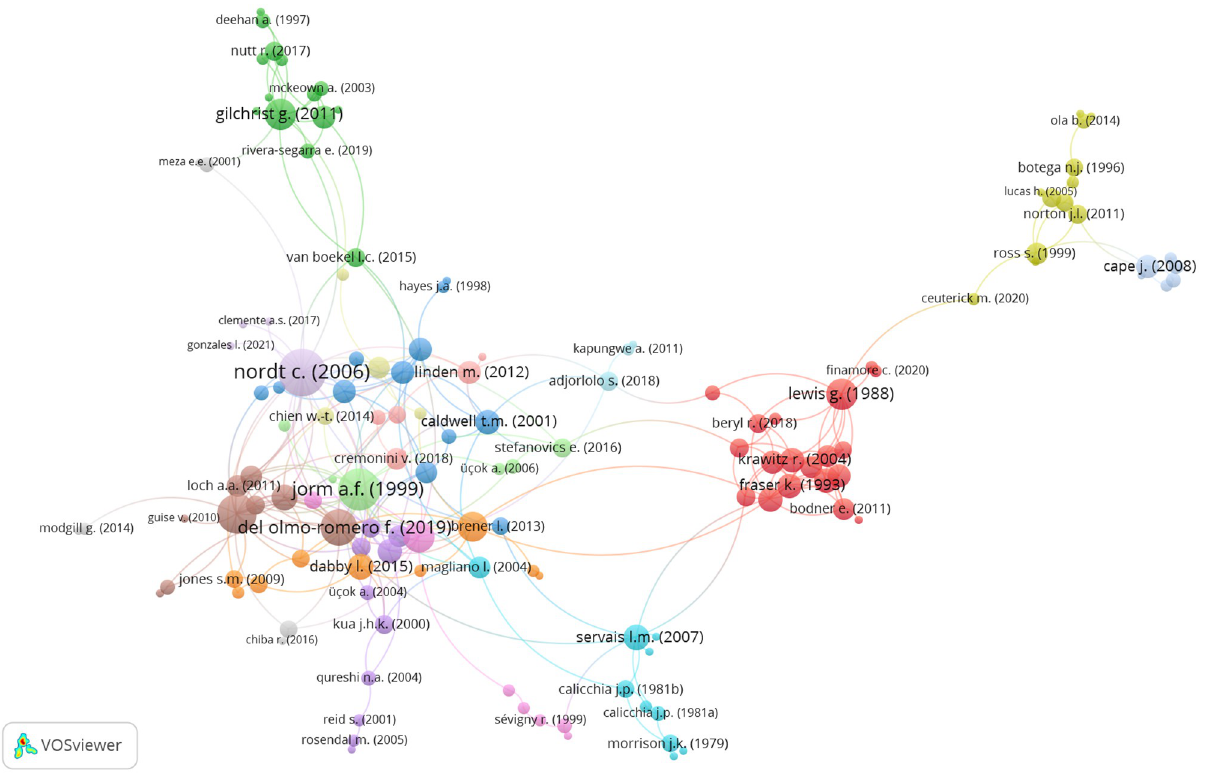
Fig 3. Central structure of